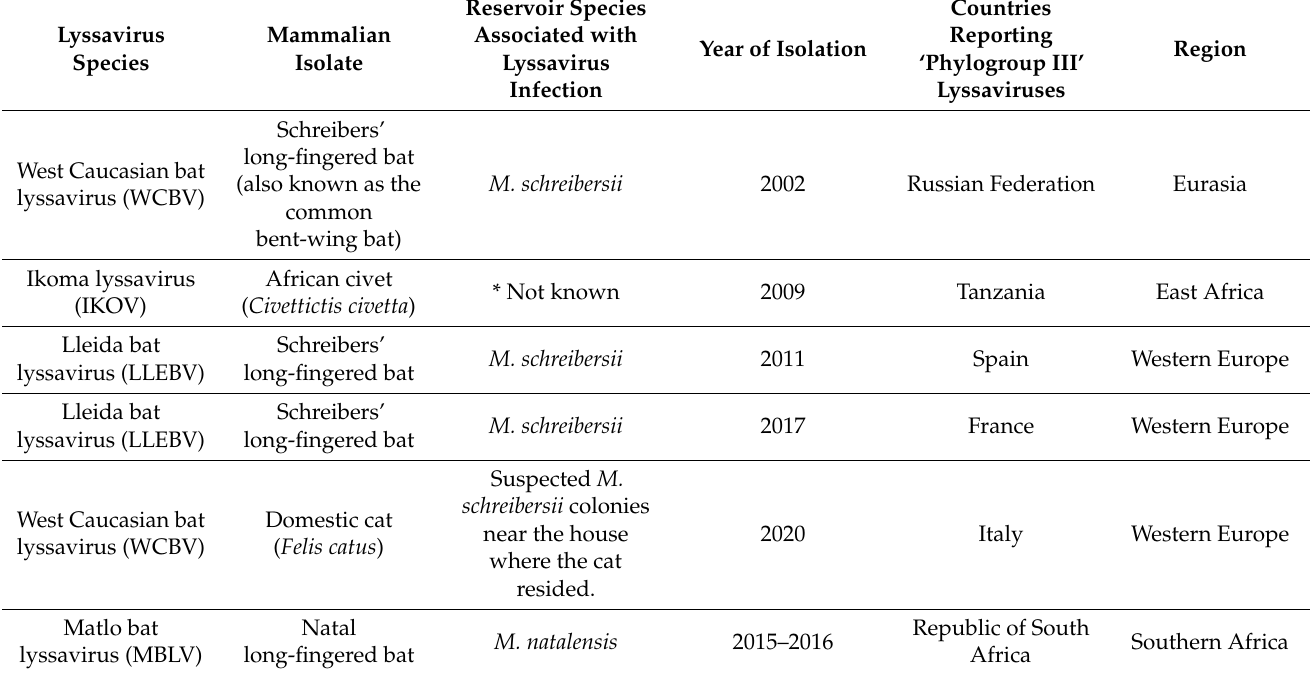
Table 1. 21st century occurrence of the proposed ‘phylogroup III’ lyssavirus